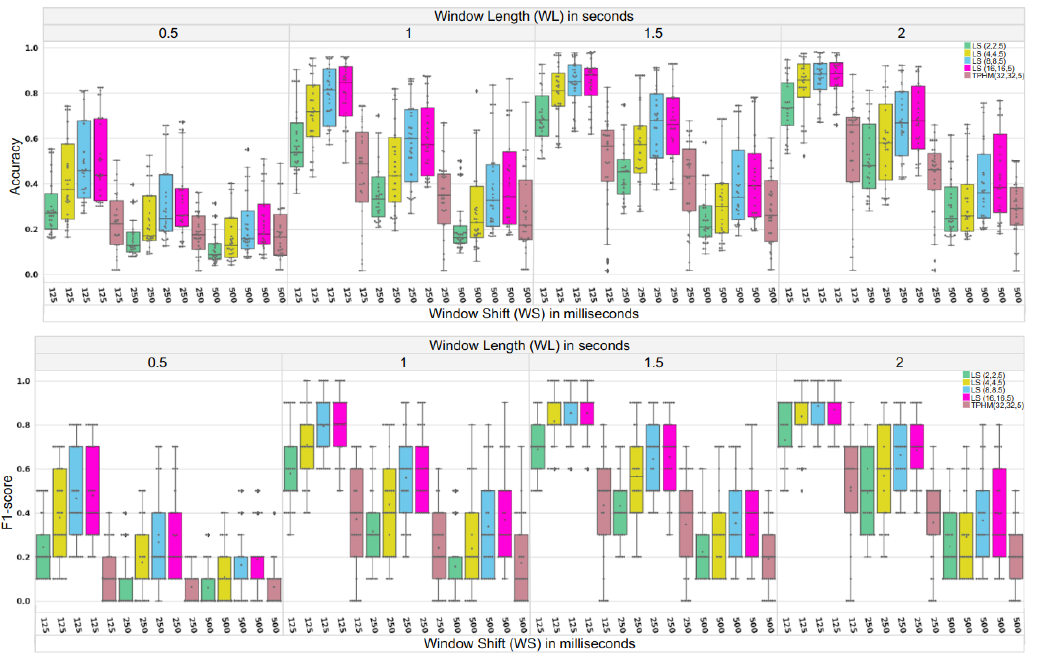
Figure 6. Utility (U) scores (Accuracy, F1-score) for 60 different DNN models with varying window length (WL), window shift (WS), and two kinds of input viz latent space (LS) and Topology Preserved Head-Maps (TPHM).